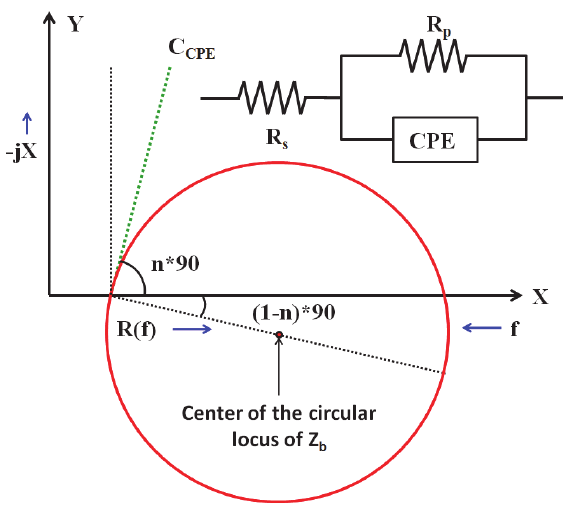
Fig.3: Nyquist plots of circuit combinations containing two sub- circuit blocks: one with series resistance, R s , and another containing a CPE in parallel with resistance R p (R p || CPE). In some cases, the Nyquist plots are semi-circular arcs with their centers some distance below the x-axis.